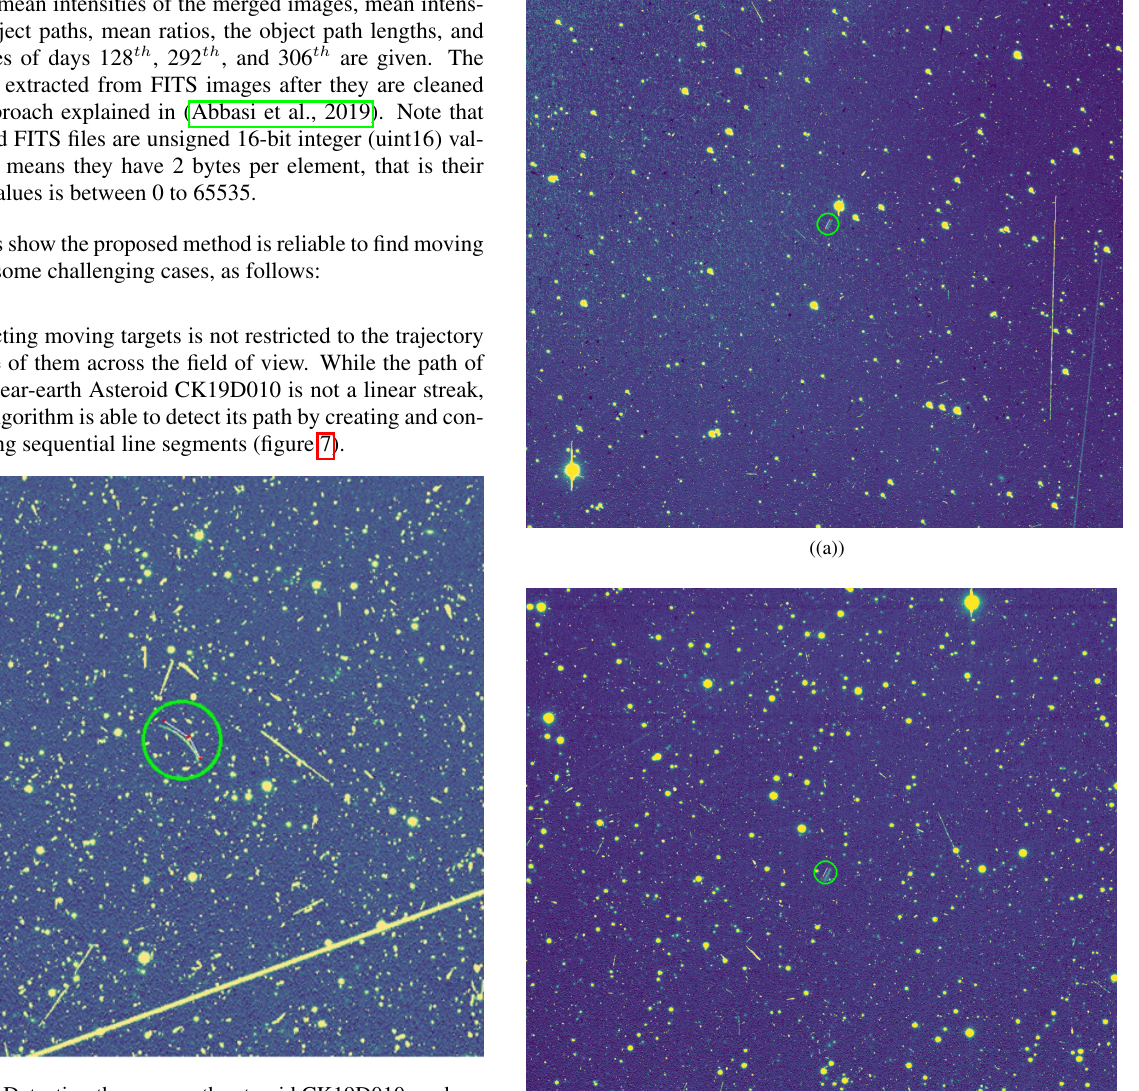
Figure 7. Detecting the near-earth asteroid CK19D010 on day 128 th of 2019, track 1, with a non-linear path in the field of view